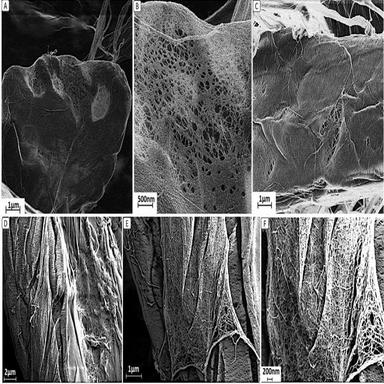
Various comparative HIM (aec) and SEM (def) micrographs on spruce never dried, critical point dried pulp: a) the edge of a cell, b) nanofibrils at the edge of the cell at high magnification, c) surface of cell wall at low magnification, d) single fiber surface covered with nanofibrils, e,f) network of nanofibrils covering the surface of the fiber.